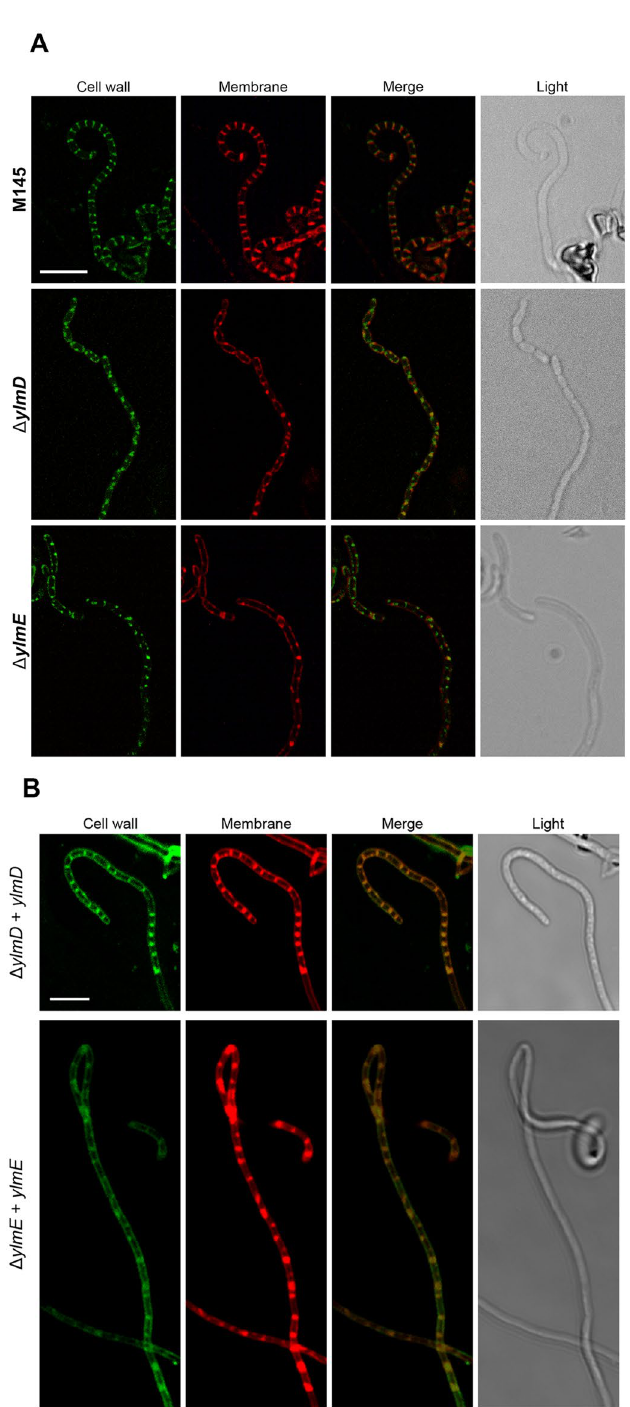
Figure 5. Fluorescence microscopy of cell wall, DNA and membranes. ( A ) Fluorescent micrographs of hyphae stained for cell-wall synthesis (FITC-WGA or Oregon-WGA) or membranes (FM5-95). An overlay of these images is presented in the third column, and the corresponding light image in the last column. Bar, 5 µ m. ( B ) Fluorescence micrographs showing DNA and cell-wall distribution in the complemented ylmD and ylmE mutants. While ladders of septa were formed in both strains, indicative that sporulation was restored to the mutants, in particular the complemented ylmE mutant formed imperfect septa. Cultures were grown on SFM agar plates for 5 days at 30 °C. Bar, 10 µ